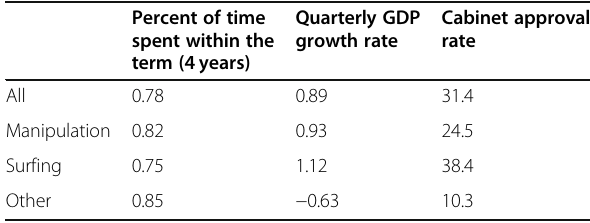
Table 4 Average Indicators Values for Each Group